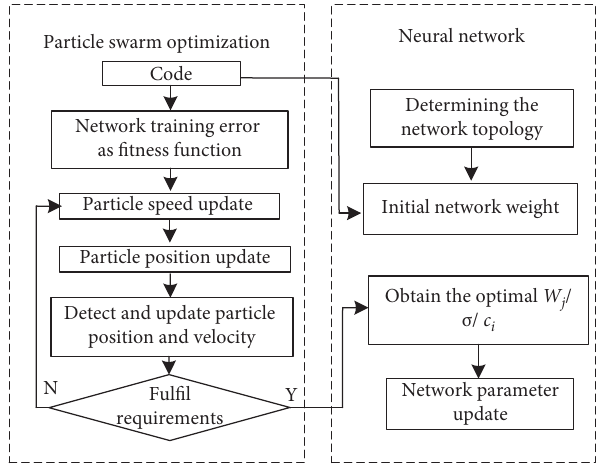
Figure 7: Schematic diagram of particle swarm optimization RBF